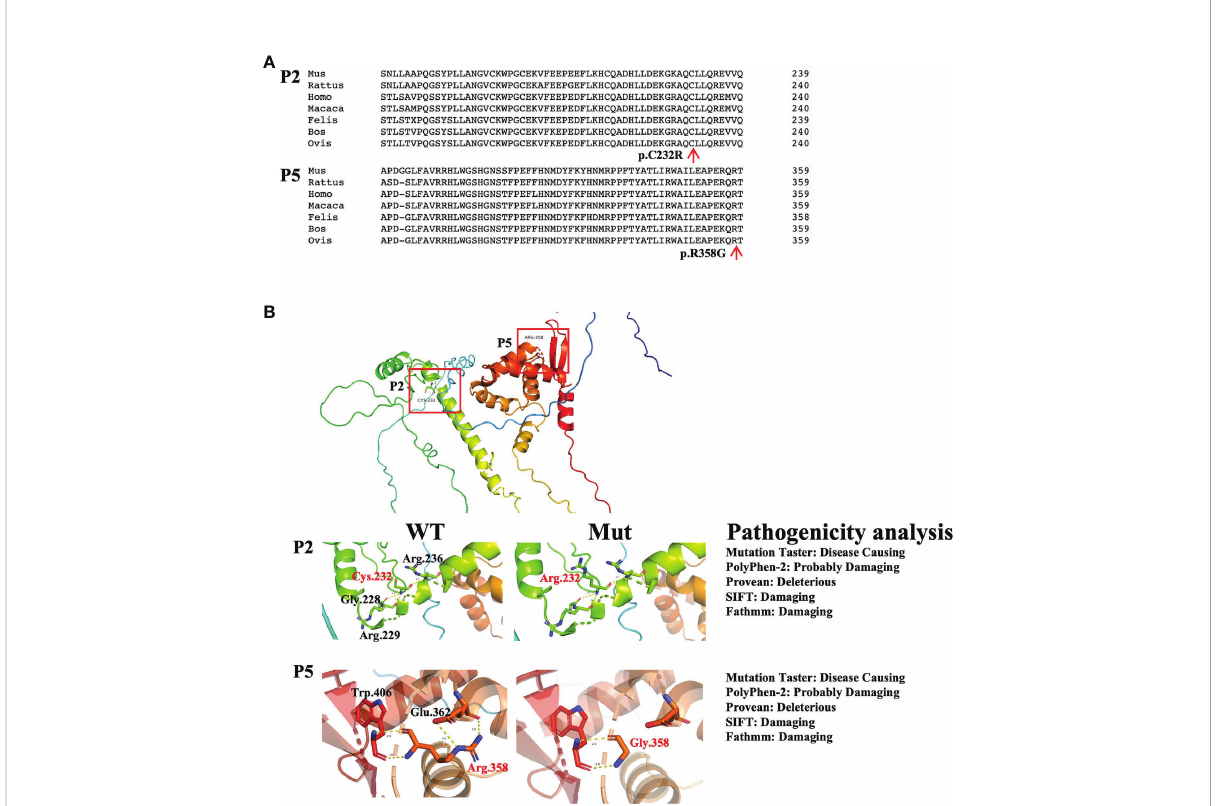
FIGURE 2 Pathogenicity analysis of the novel mutations. (A) Conserved analysis of amino acid sequences in different species by Clustal Omega. The red arrows refer to mutated amino acid sites. (B) The left panel shows the structural impacts of the mutations on the FoxP3 structure (PDB: 4wk8), which were analyzed by PyMOL. Hydrogen bonds are shown as dotted lines. Red indicates mutated amino acids, and black indicates amino acids around the mutations. The right panel shows the results of the pathogenicity analysis of novel mutations by MutationTaster, PolyPhen-2, Provean, SIFT and